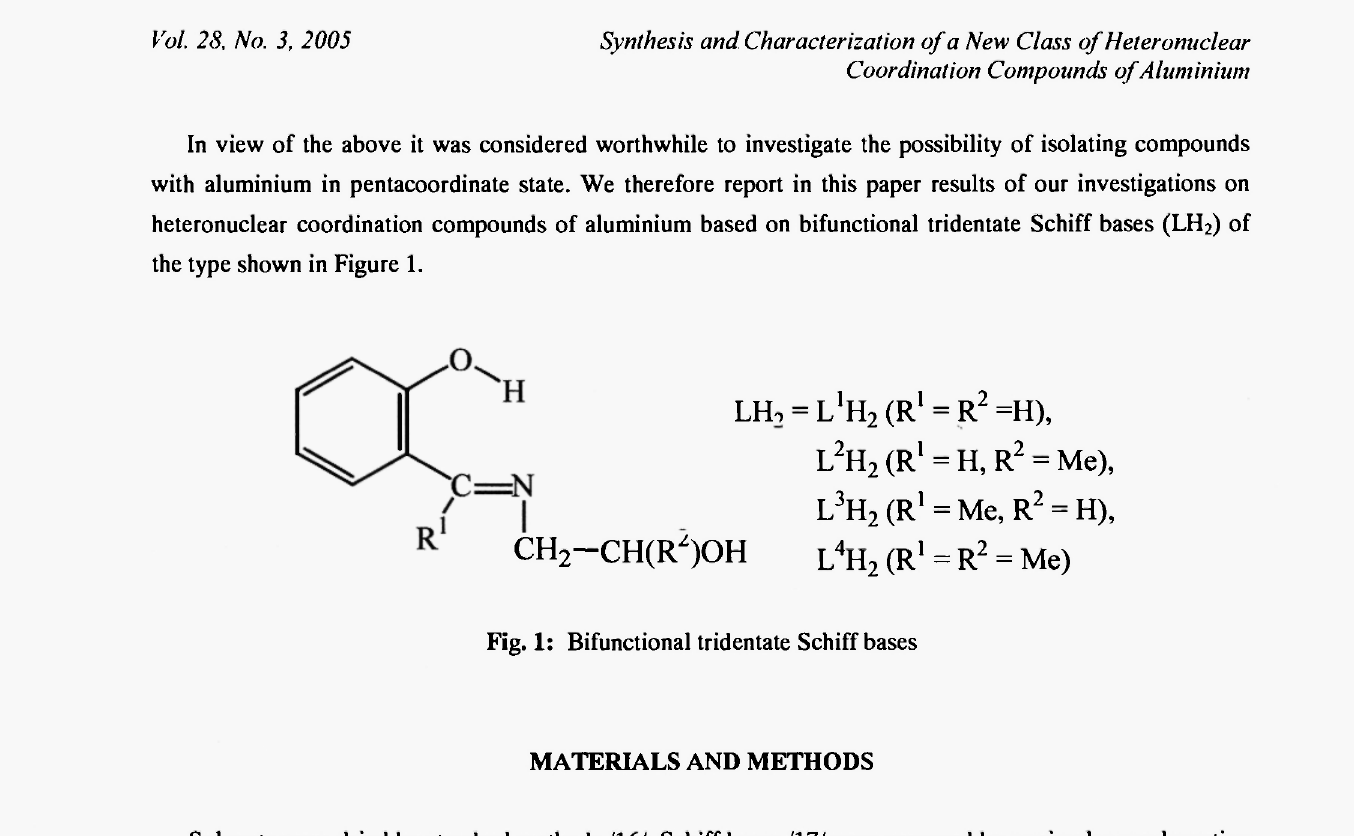
Fig. 1: Bifunctional tridentate Schiff